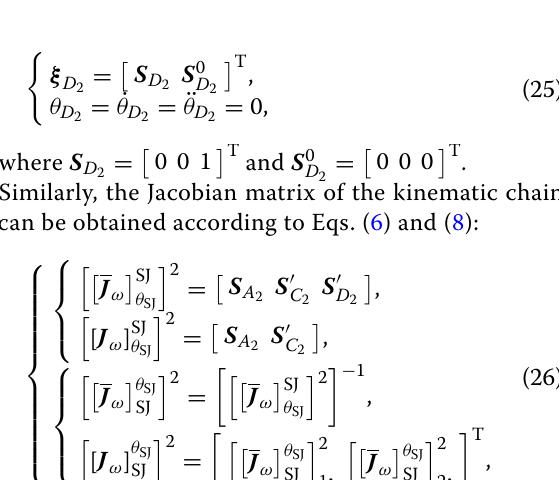
(b) Mechanism diagram of the HSJ Figure 6 Structural configuration of the HSJ